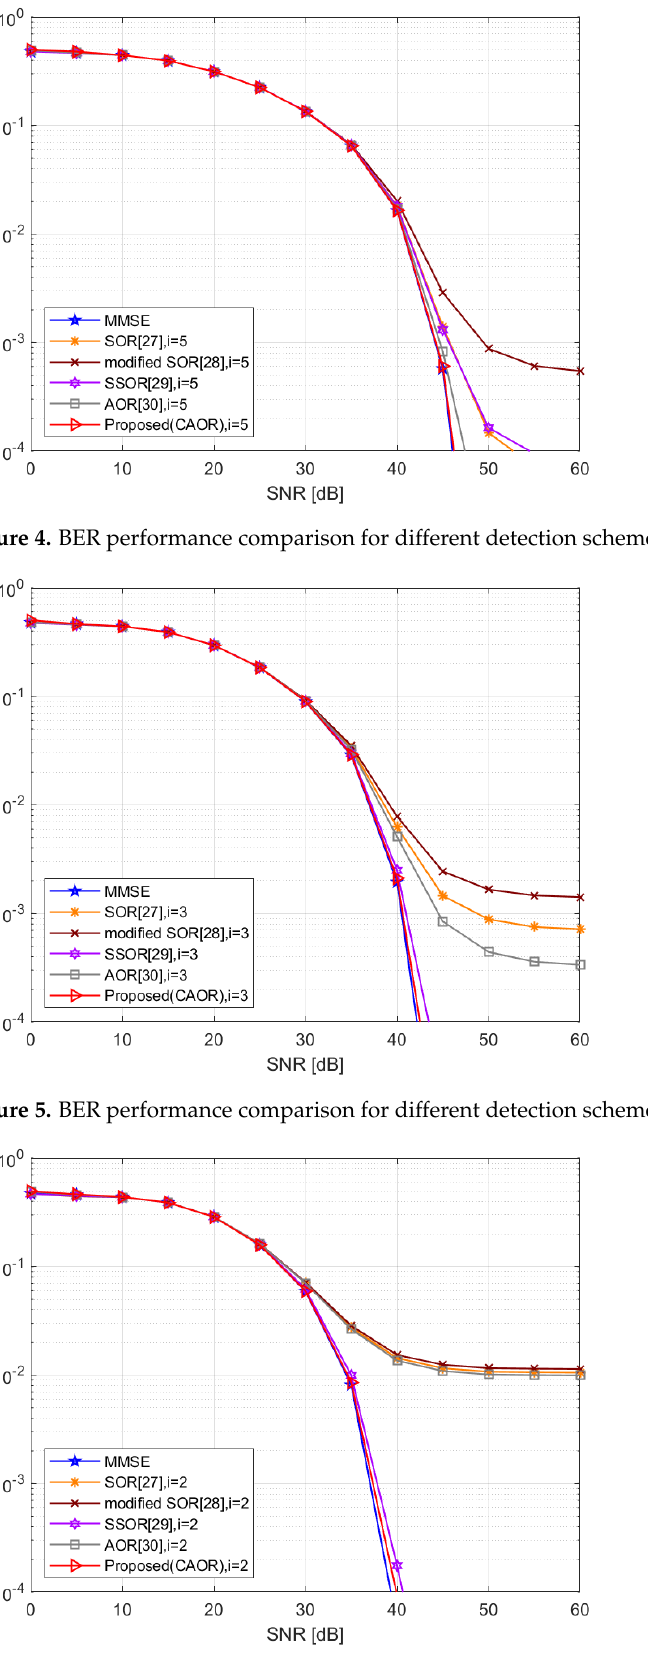
Figure 6. BER performance comparison for different detection schemes, N R × N T = 256 ×